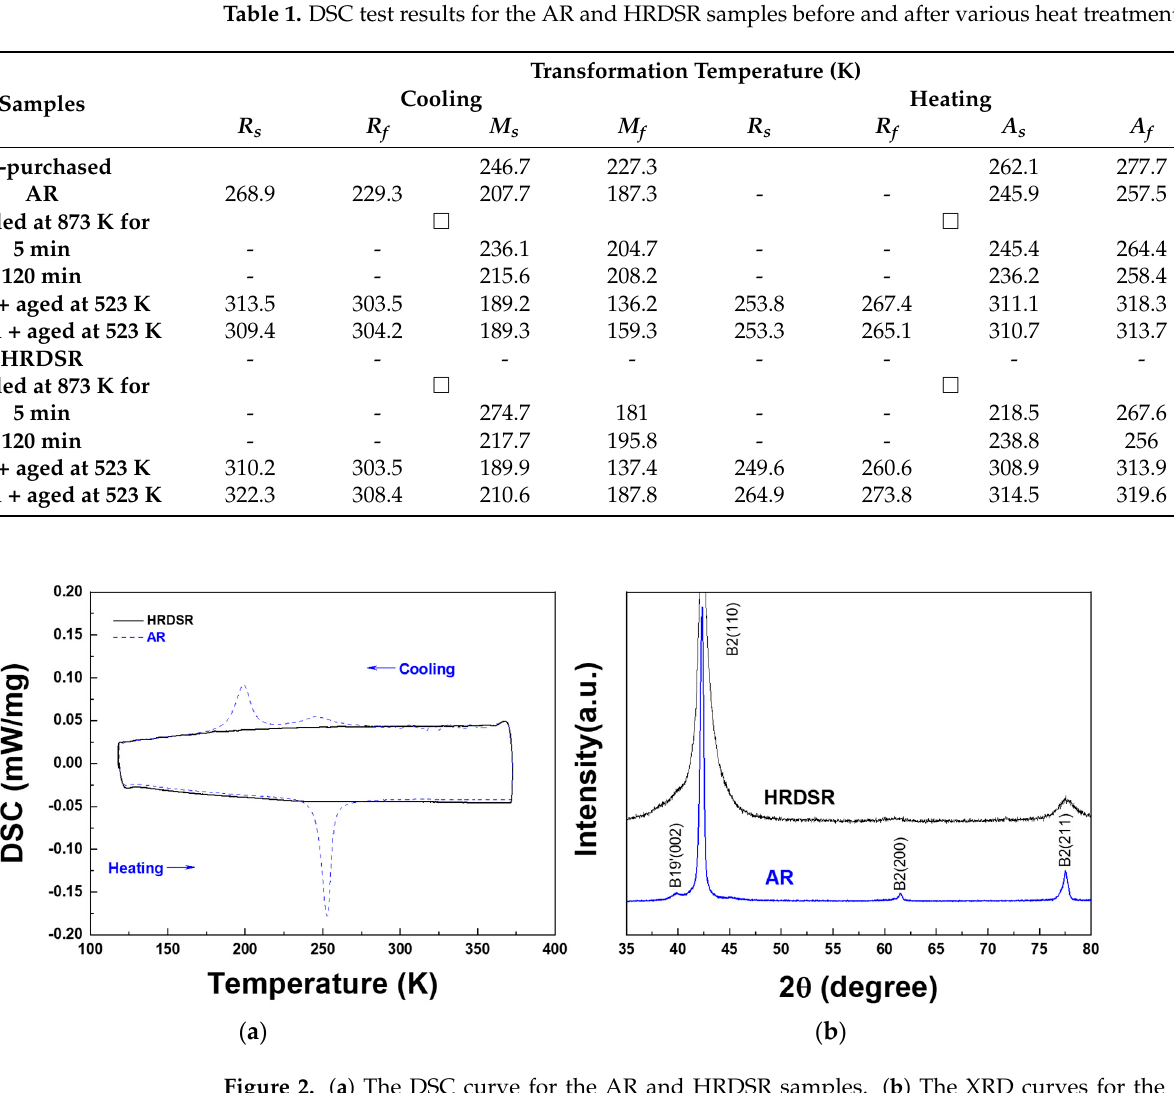
Table 1. DSC test results for the AR and HRDSR samples before and after various heat treatments.